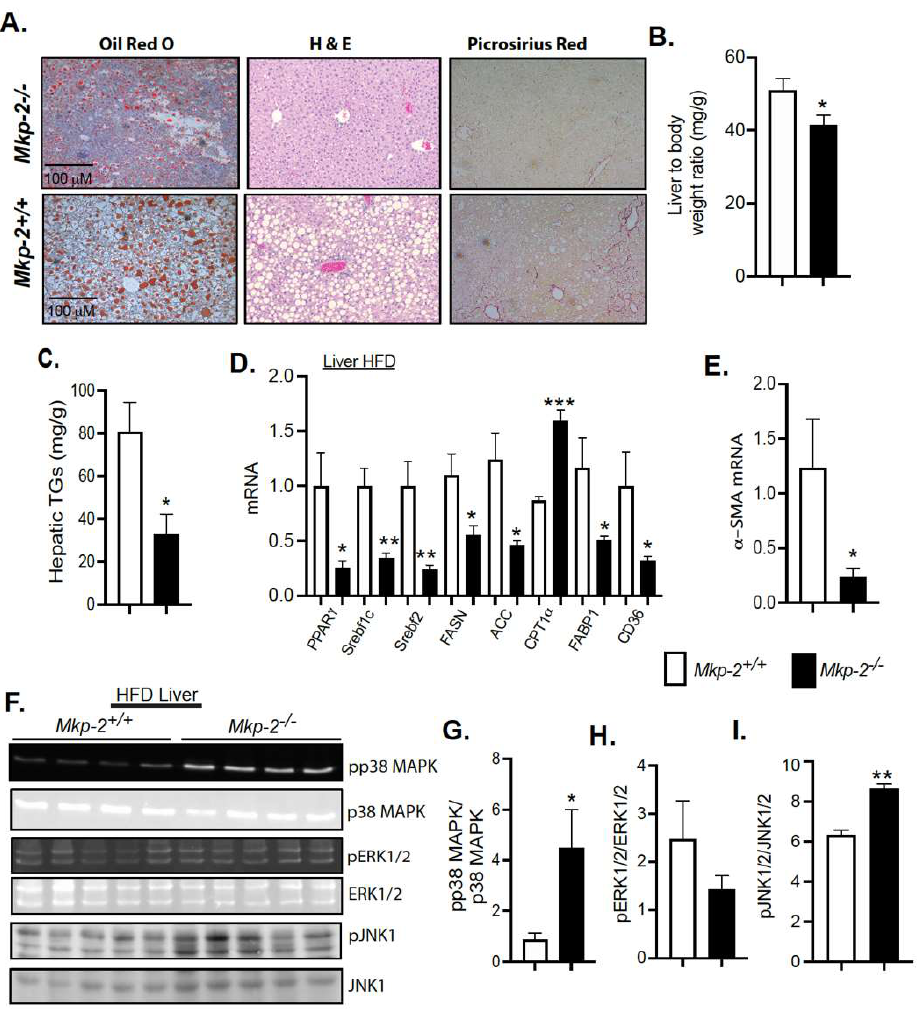
Figure 5. Protection from the Development of Hepatic Steatosis in HFD-fed Male MKP-2-Deficient Mice. ( A ) Representative hematoxylin and eosin staining, Oil Red O and Picrosirius red staining of liver sections from HFD-fed Mkp-2 −/− mice (( A ), upper panel) and Mkp-2 +/+ mice (( A ), lower panel) mice for 24 weeks (N = 5 mice/genotype). ( B ) Liver weights; ( C ) hepatic TGs; ( D ) hepatic mRNA expression of PPARγ, Srebf1c, Srebf2, FASN, ACC, CPT1α, FABP1 and CD36; and ( E ) alpha smooth muscle actin. Representative immunoblots were quantitated by densitometry for phospho-p38 MAPK/p38 (( F ) upper panel and ( G )), phospho-JNK1/2/JNK1/2 (( F ) lower panel and ( I )), and phospho-ERK1/2ERK1/2 (( F ) middle panel ( H )) in HFD livers. Results represent the mean ± SEM; * p < 0.05, ** p < 0.01, *** p < 0.0001 as determined by Student’s t -test or in ( D ) by analysis of variance (ANOVA) with Bonferroni’s post-test for multiple comparisons. Open bars, Mkp-2 +/+ mice; closed bars, Mkp-2 −/− mice.